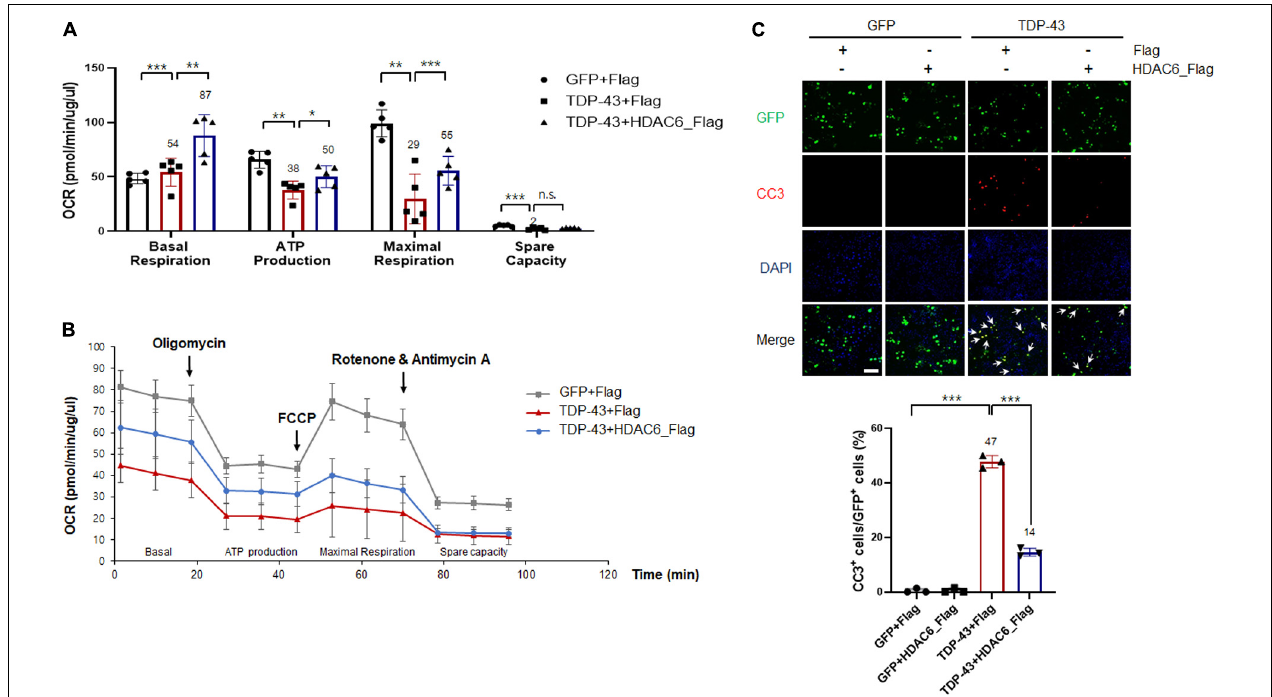
FIGURE 4 | HDAC6 attenuates TDP-43-induced mitochondrial dysfunction and neurotoxicity in N2a cells. (A,B) Stable Flag- or HDAC6-Flag-expressing cells were transfected with either Gfp or TDP-43-Gfp expression constructs, grown for 2 days, and then analyzed. (A) Mitochondrial dysfunction analysis of Gfp -transfected sorted cells to detect the basal OCR, ATP production, maximum reserve, and respiratory capacity by a Seahorse XF Analyzer. The OCR was normalized to the total protein concentration. (B) Quantification of the basal respiration, ATP production, maximum respiration, and spare respiratory capacity is shown as a percentage of the basal values. Data are presented as the mean ± SEM. * p < 0.05, ** p < 0.005, *** p < 0.001, and n.s. , not significant (two-way ANOVA with Tukey’s multiple comparison test). (C) Stable Flag- or HDAC6-Flag-expressing cells were transfected with either Gfp or TDP-43-Gfp vector were stained for cleaved caspase-3 (CC3; red) or DAPI (nuclei; blue). Arrowheads indicate the colocalization of CC3 with TDP-43-GFP-positive cells. Data are presented as the mean ± SD of three independent experiments. *** p < 0.001 (one-way ANOVA with Tukey’s multiple comparison test). Scale bars, 50 µ